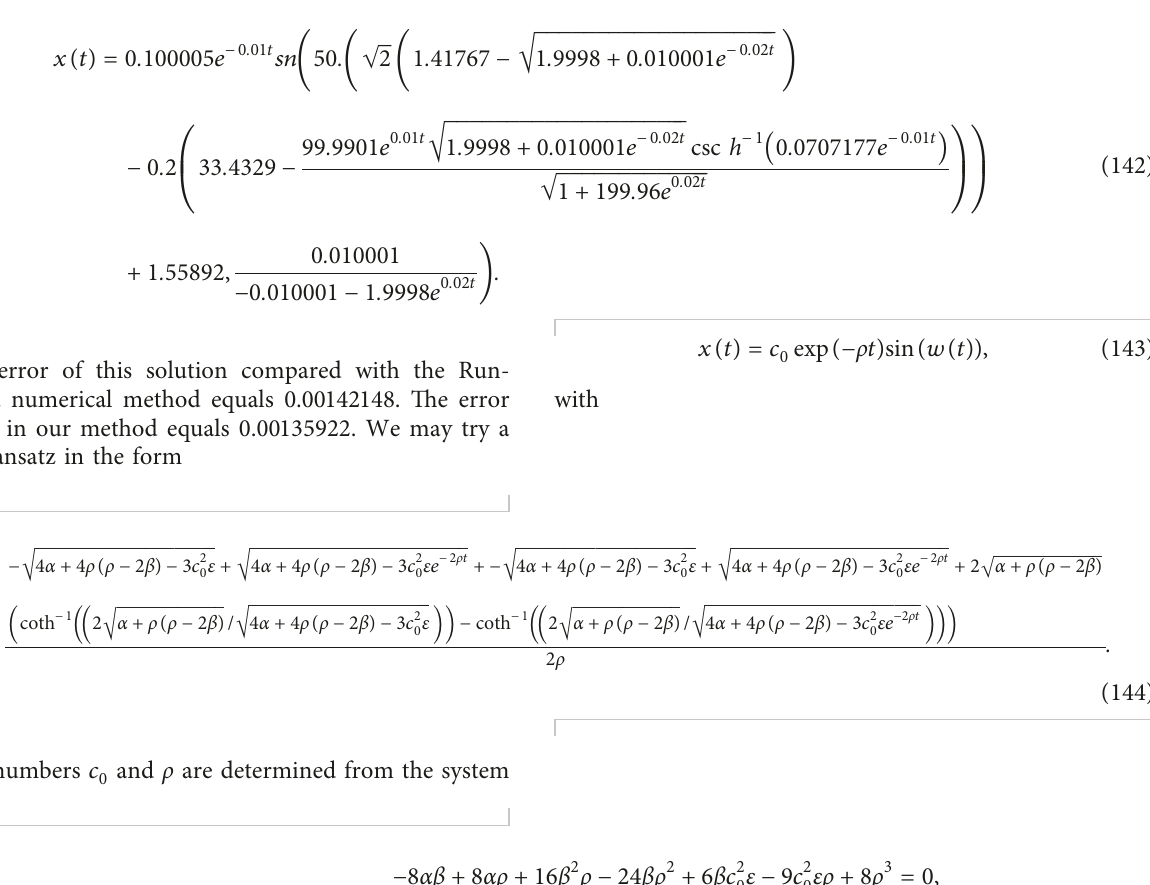
Figure 11: Comparison between the approximate analytical solution and the homotopy solution for Example